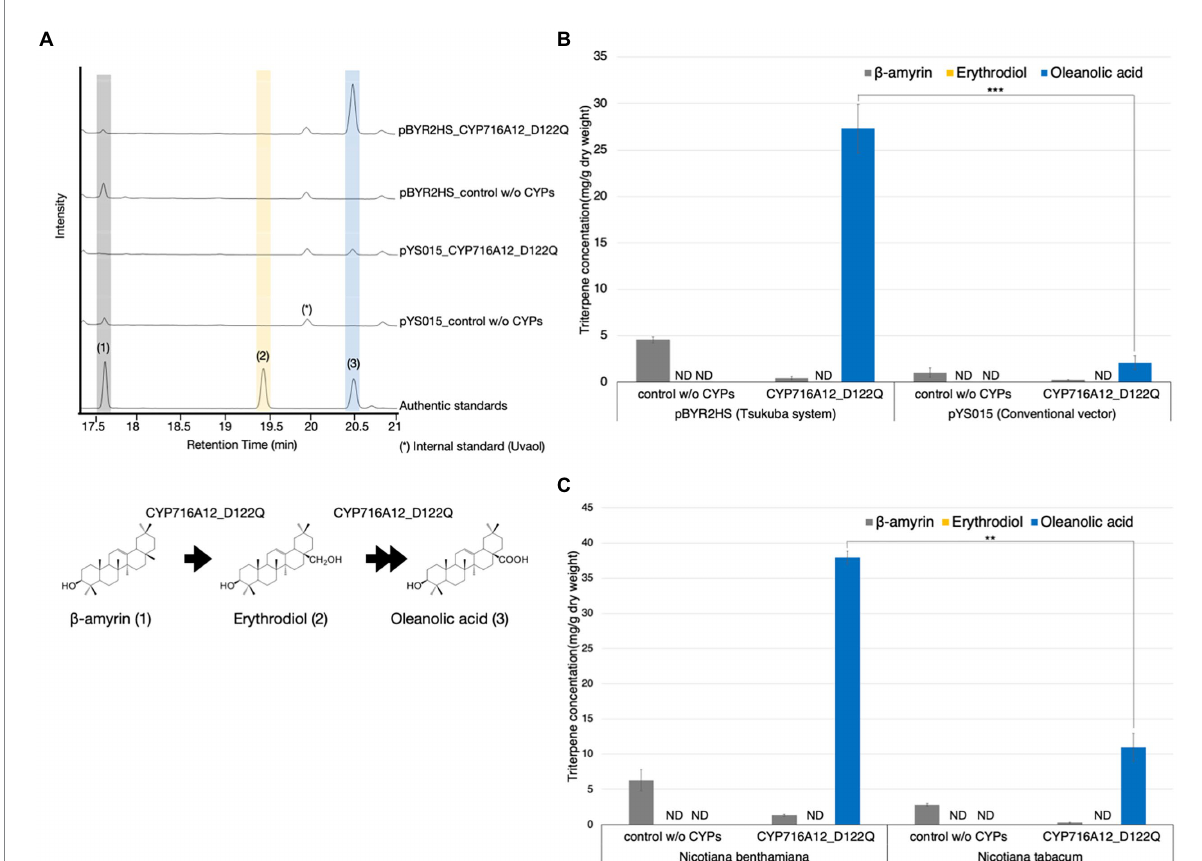
FIGURE 1 Comparison of the accumulation of oleanolic acid in leaves from different expression systems and Nicotiana species. (A) Total ion chromatograms (TICs) of extracts from Nicotiana benthamiana leaves infiltrated with a mixture of Agrobacterium tumefaciens harboring pBYR2HS expressing LjOSC1, LjCPR2, and CYP716A12_D122Q or a combination of the pYS_015 vector expressing LjOSC, LjCPR2, CYP716A12_D122Q, and p19. As a background control, a combination of pBYR2HS expressing LjOSC, LjCPR2, and empty vector or pYS015 binary vector expressing LjOSC1, LjCPR2, empty vector, and p19 was used. β -Amyrin ( 1 ), erythrodiol ( 2 ), and oleanolic acid ( 3 ) were used as authentic standards. Uvaol (*) was used as an internal standard. (B) Comparison of triterpene concentrations in N . benthamiana leaves infiltrated with different expression vectors. (C) Comparison of the triterpene concentrations in infiltrated leaves of N . benthamiana and N . tabacum . Data are representative of at least three biological replicates ( n = 3) and are expressed as the mean ± SEM. Differences in oleanolic acid production were examined using Student’s t -test for each sample. ** p < 0.01; *** p < 0.001; ND, not